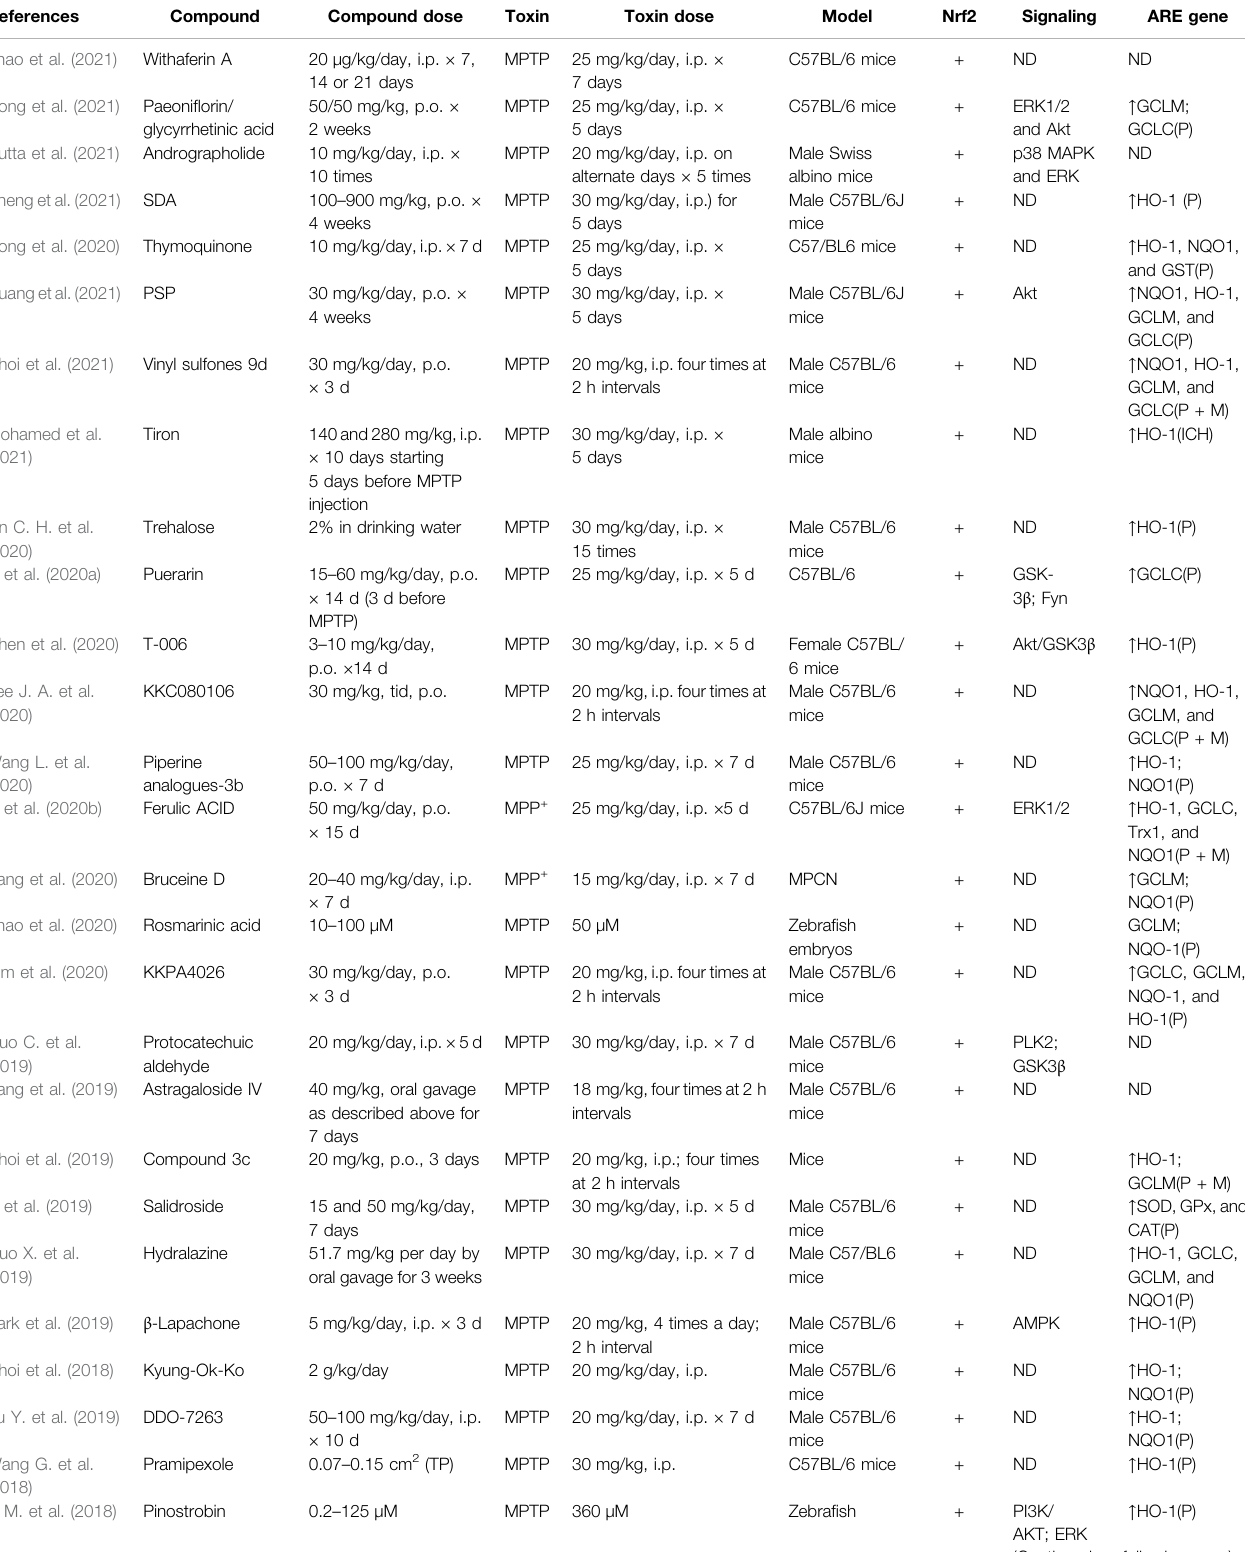
TABLE 4 | Summary of the experimental studies involving compounds able to modulate Nrf2 pathway in MPTP-induced PD